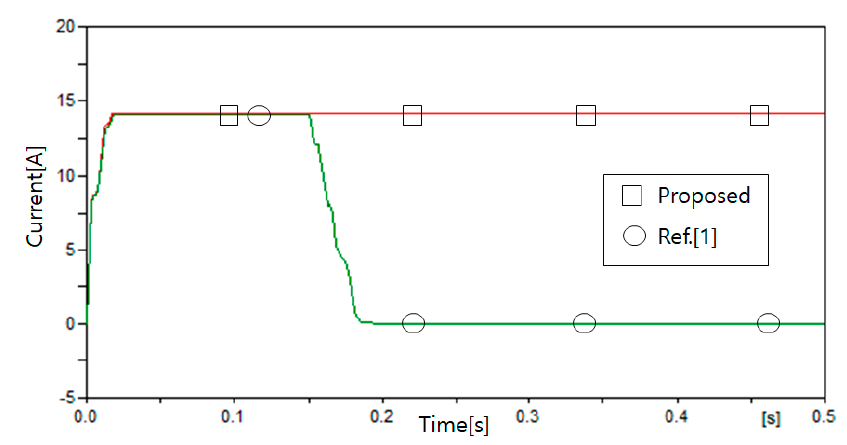
Figure 29. Current measured at I 2 in Case 8.